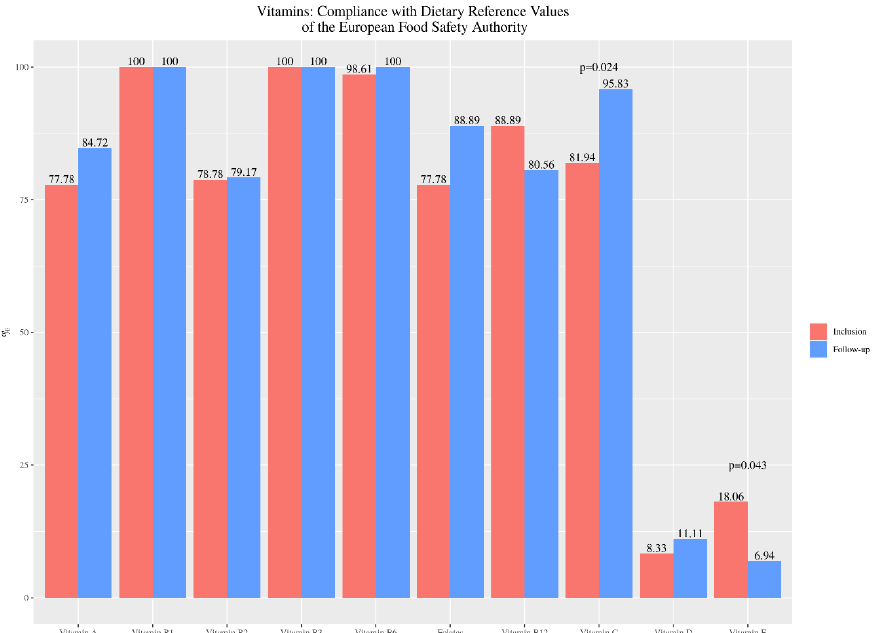
Figure 3. Percentage of celiac children’s compliance with the recommendations for vitamins intake, from baseline (inclusion) to twelve months after nutrition education (follow-up).